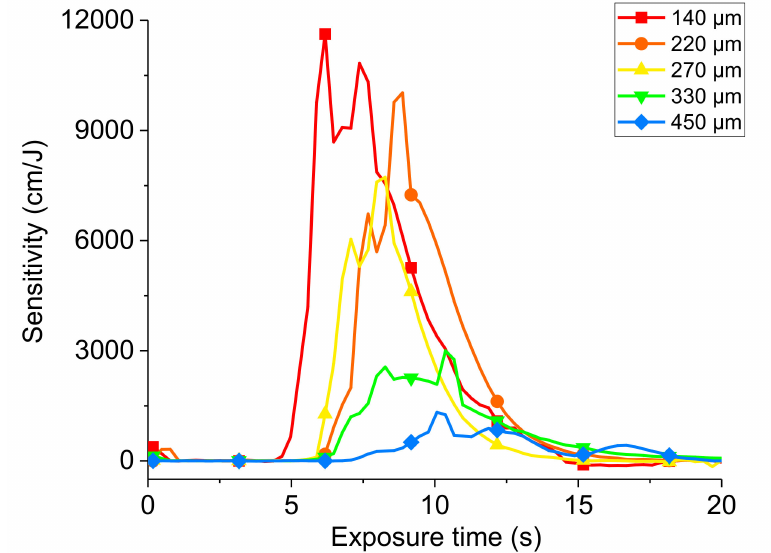
Figure 4. Dependence of S on the exposure time for the P-2